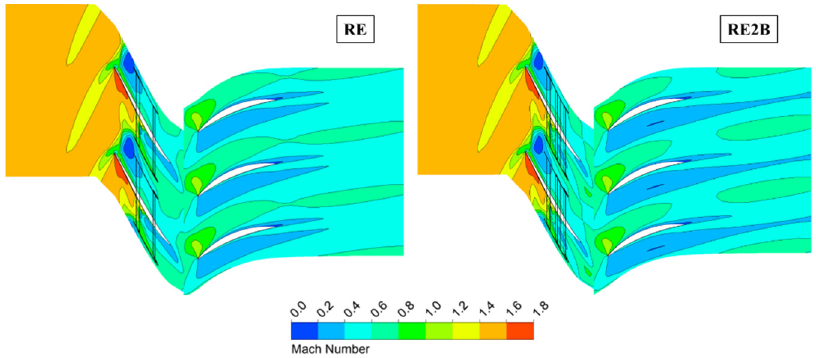
Figure 8. Relative Mach number contours at 98% rotor blade span at near-stall condition.